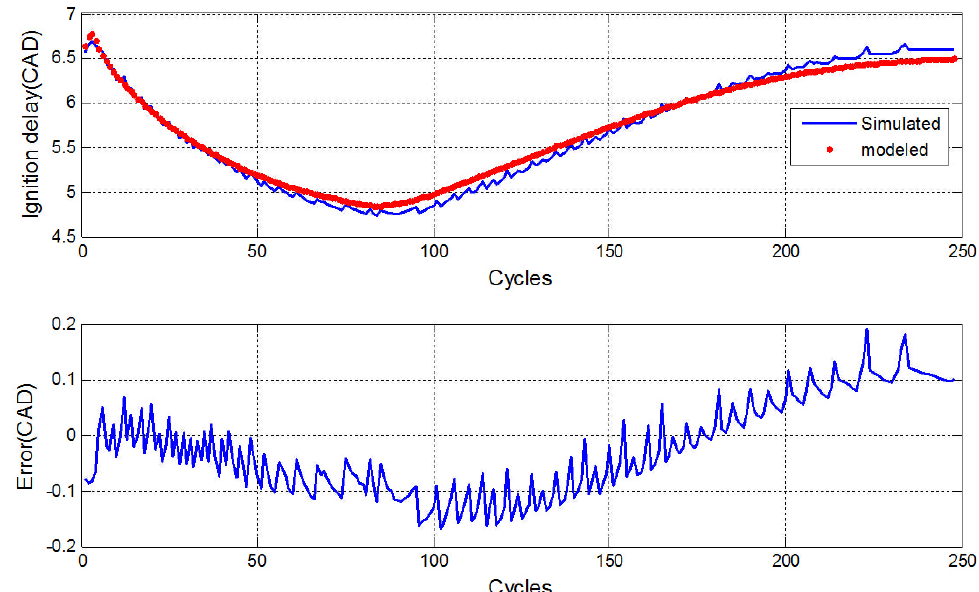
Figure 6. Comparison between the modeled and simulation ignition